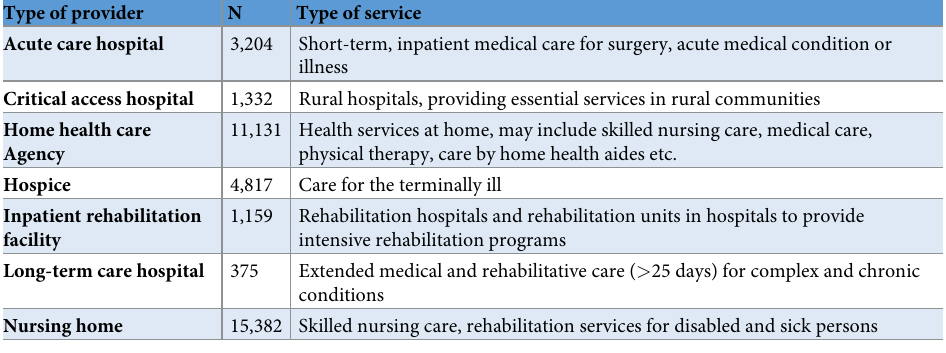
Table 1. Nationwide provider data type and services, for contiguous US area (Alaska & Hawaii excluded from analysis).